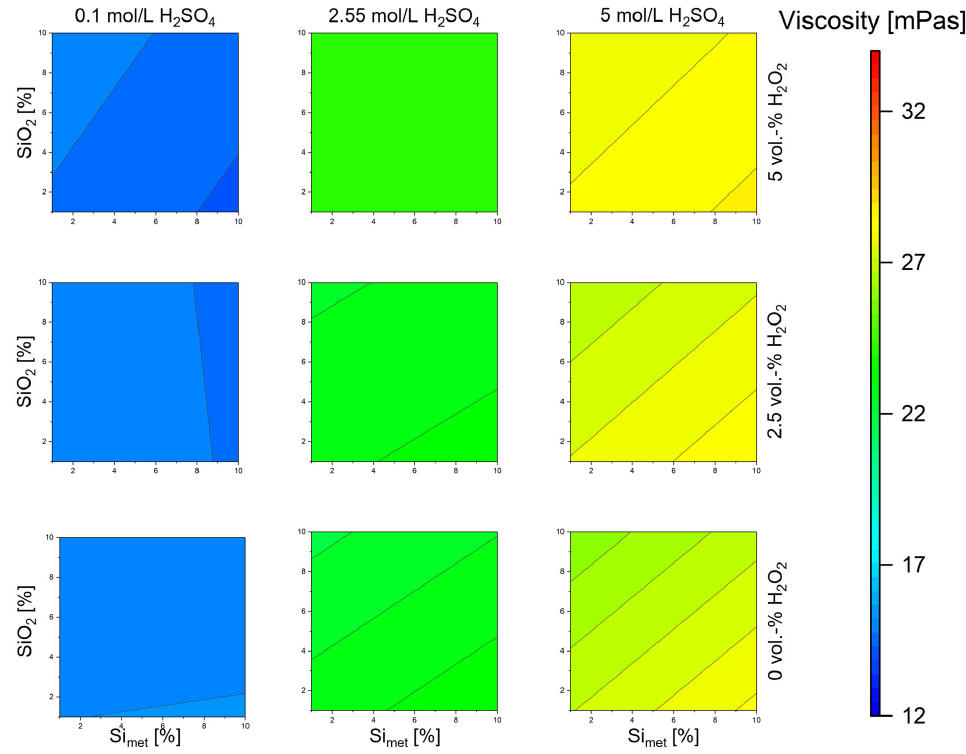
Metals 2023 , 13 , x FOR PEER REVIEW Figure 7. 4D contour plot for the change in viscosity as a function of Si met , SiO 2 , H 2 SO 4 and H 2 O 2 concentration in the leaching solution at an S/L ratio of 50 g/L and a leaching temperature of 40 °C. In comparison, in Figure 8, at a leaching temperature of 80 °C and a constant S/L ratio of 50 g/L, an increase in viscosity can already be observed at lower H 2 SO 4 and H 2 O 2 con ‐ centrations. Due to the faster kinetics at a higher temperature, the reaction sequence to ‐ wards metasilicic acid can thus also be influenced. At maximum concentrations of leach ‐ ing and reducing agents (5 mol/L H 2 SO 4 and 5 vol. ‐ % H 2 O 2 ), an increase in the maximum appearing viscosity is also evident, compared to Figure 7.